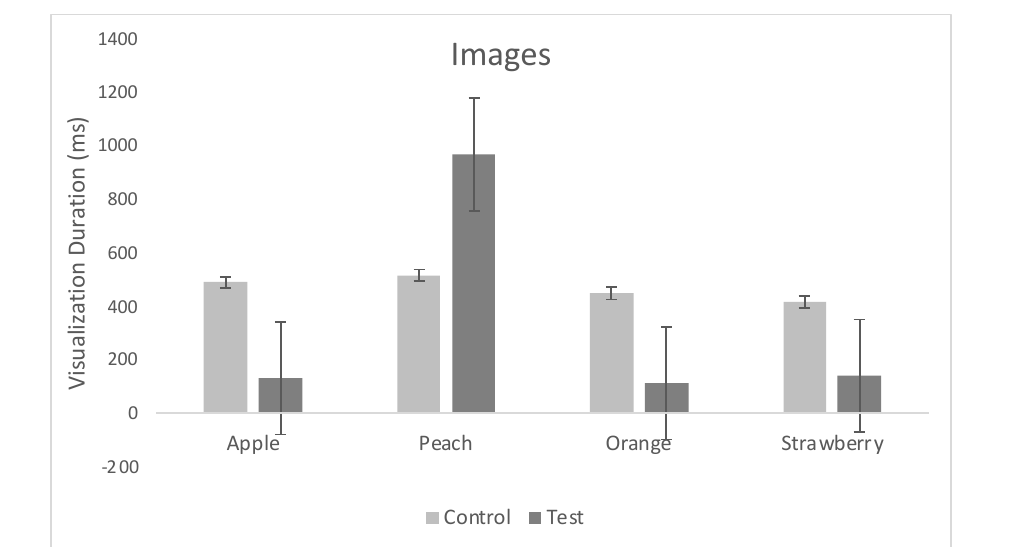
FIGURE 5 – Dwell time for different images of fruits (apple, peach, orange, and strawberry) before applying the fragrances (control) and after administering the olfactory stimulus